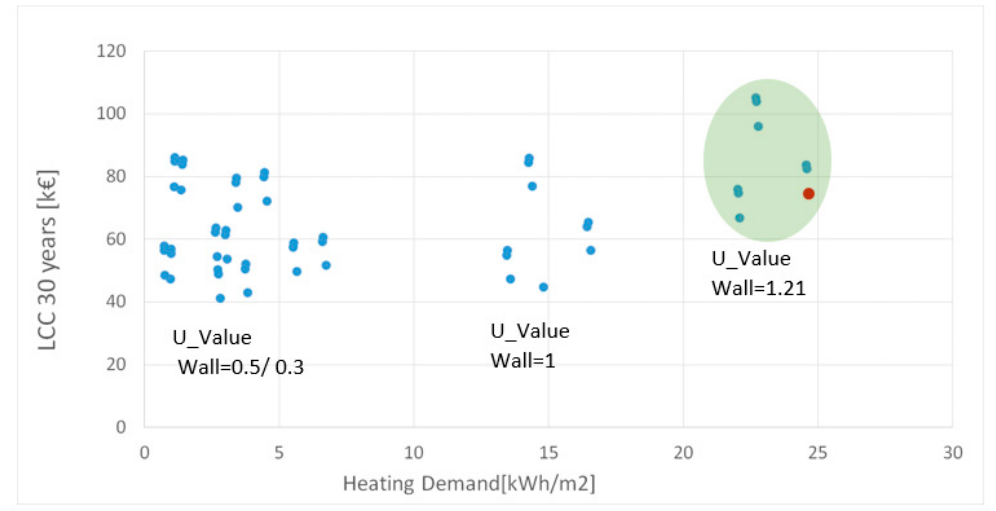
Figure 6. Life cycle cost results for heating demand—conventional catalog.